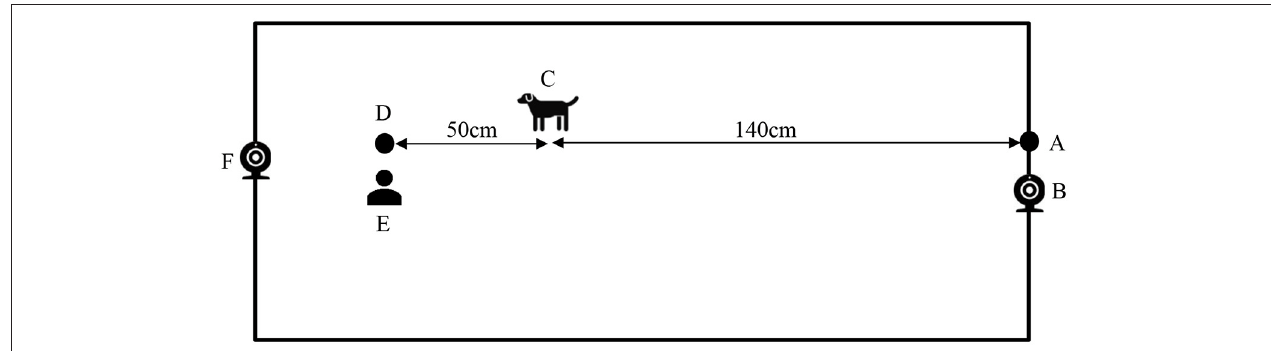
FIGURE 2 | Illustration of the study area. The leash tension metre along with a l.4-metre-long dog leash was connected to the fixed point (A) , giving the dog an approximately 1.4-m maximal movement distance (C) . The attractant was placed on the floor 50cm forward of the 1.4-metre maximal movement distance (D) and the experimenter knelt next to the attractant (E) . One camera was set next to the fixed point (B) and the other was set on the other side of the room (F) .